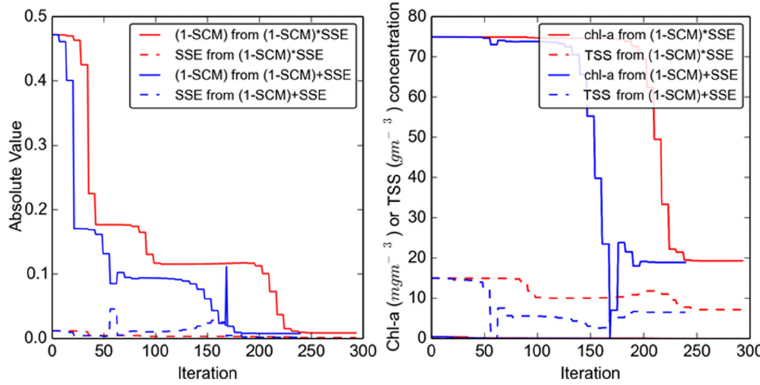
Figure 10. Representative values of the two hybrid objective functions and constituent concentrations during model optimization.